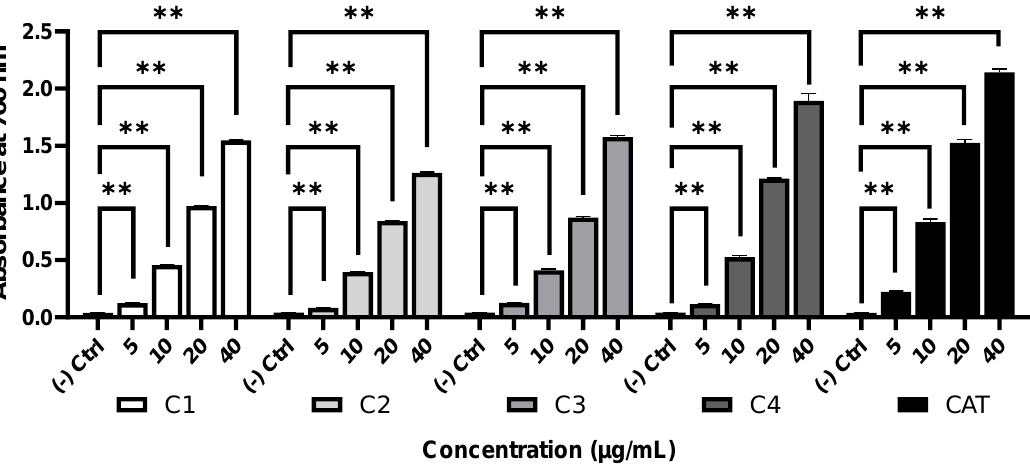
Figure 3. Reducing power of the compounds 1 - 4 . Data are represented as mean ± SD (n = 3). * p < 0.05, ** p < 0.01, significant difference compared with the control group. 1 , (-) kaur- 16α -hydroxy-19- oic acid; 2 , (-) kaur-16-en-19-oic acid; 3 , β -sitosterol; 4 , cholesta-5,23-dien-3-ol; CAT, catechin.